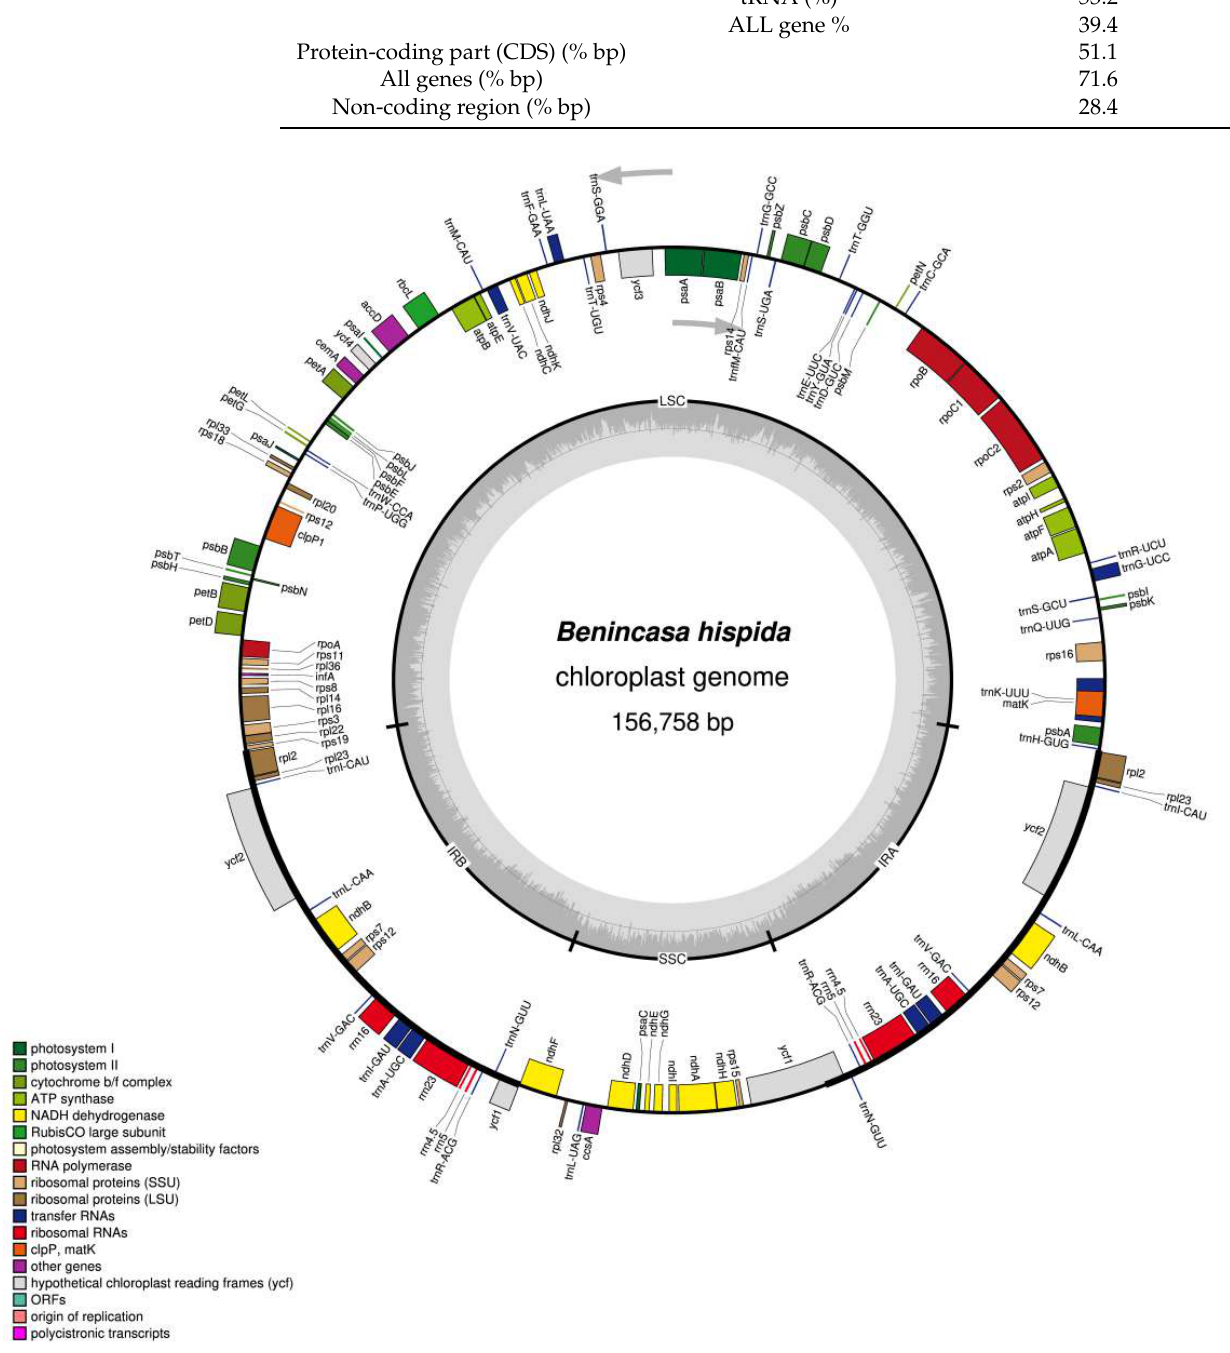
Figure 1. Gene map of the Benincasa hispida chloroplast genome. The genes drawn outside and inside of the circle are transcribed in clockwise and counterclockwise directions. Genes are colored based on their function. The borders of chloroplast genome are defined with LSC, SSR, IRa, and IRb. The dashed gray color of the inner circle shows the GC content, whereas the lighter gray color shows AT content. Asterisks mark genes that have